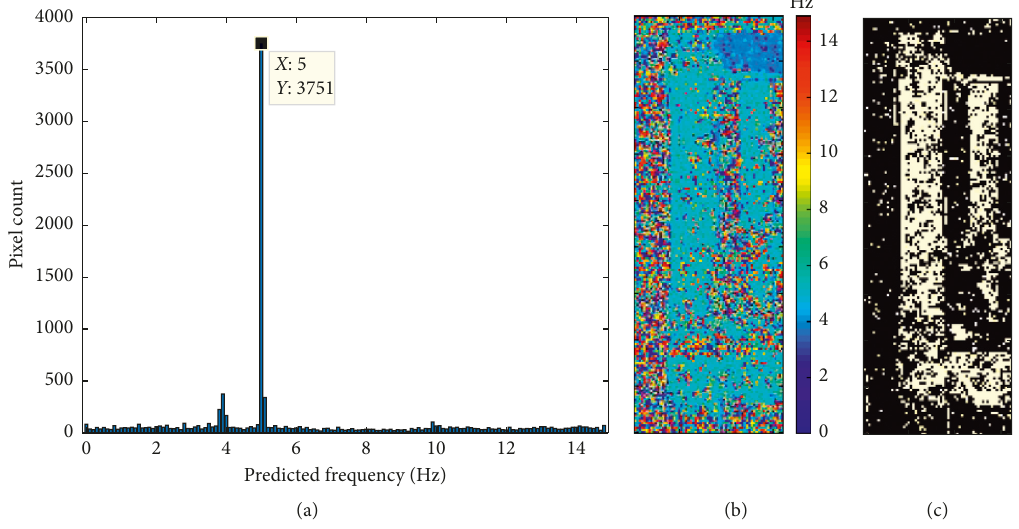
Figure 15: Verification test results for an excitation frequency of 5Hz. (a) Histogram of predicted frequency distribution. (b) Prediction outputs visualization in their original spatial position. (c) Highlighted pixels predicted as 5Hz for verification.